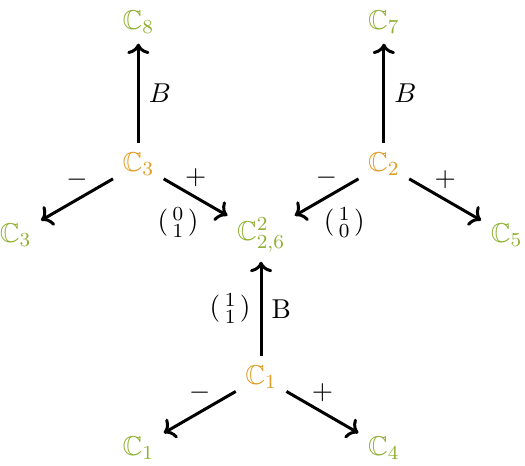
Figure 10. Kronecker-3 quiver.